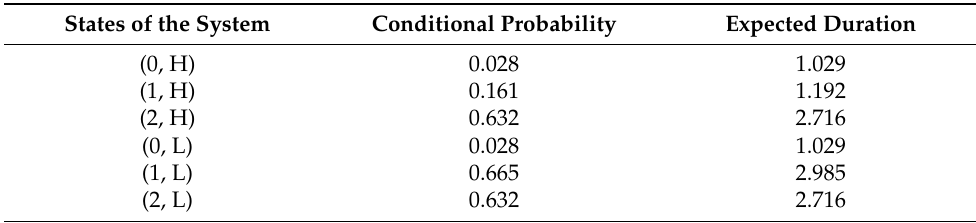
Table 18. Conditional probability and the expected duration With two active